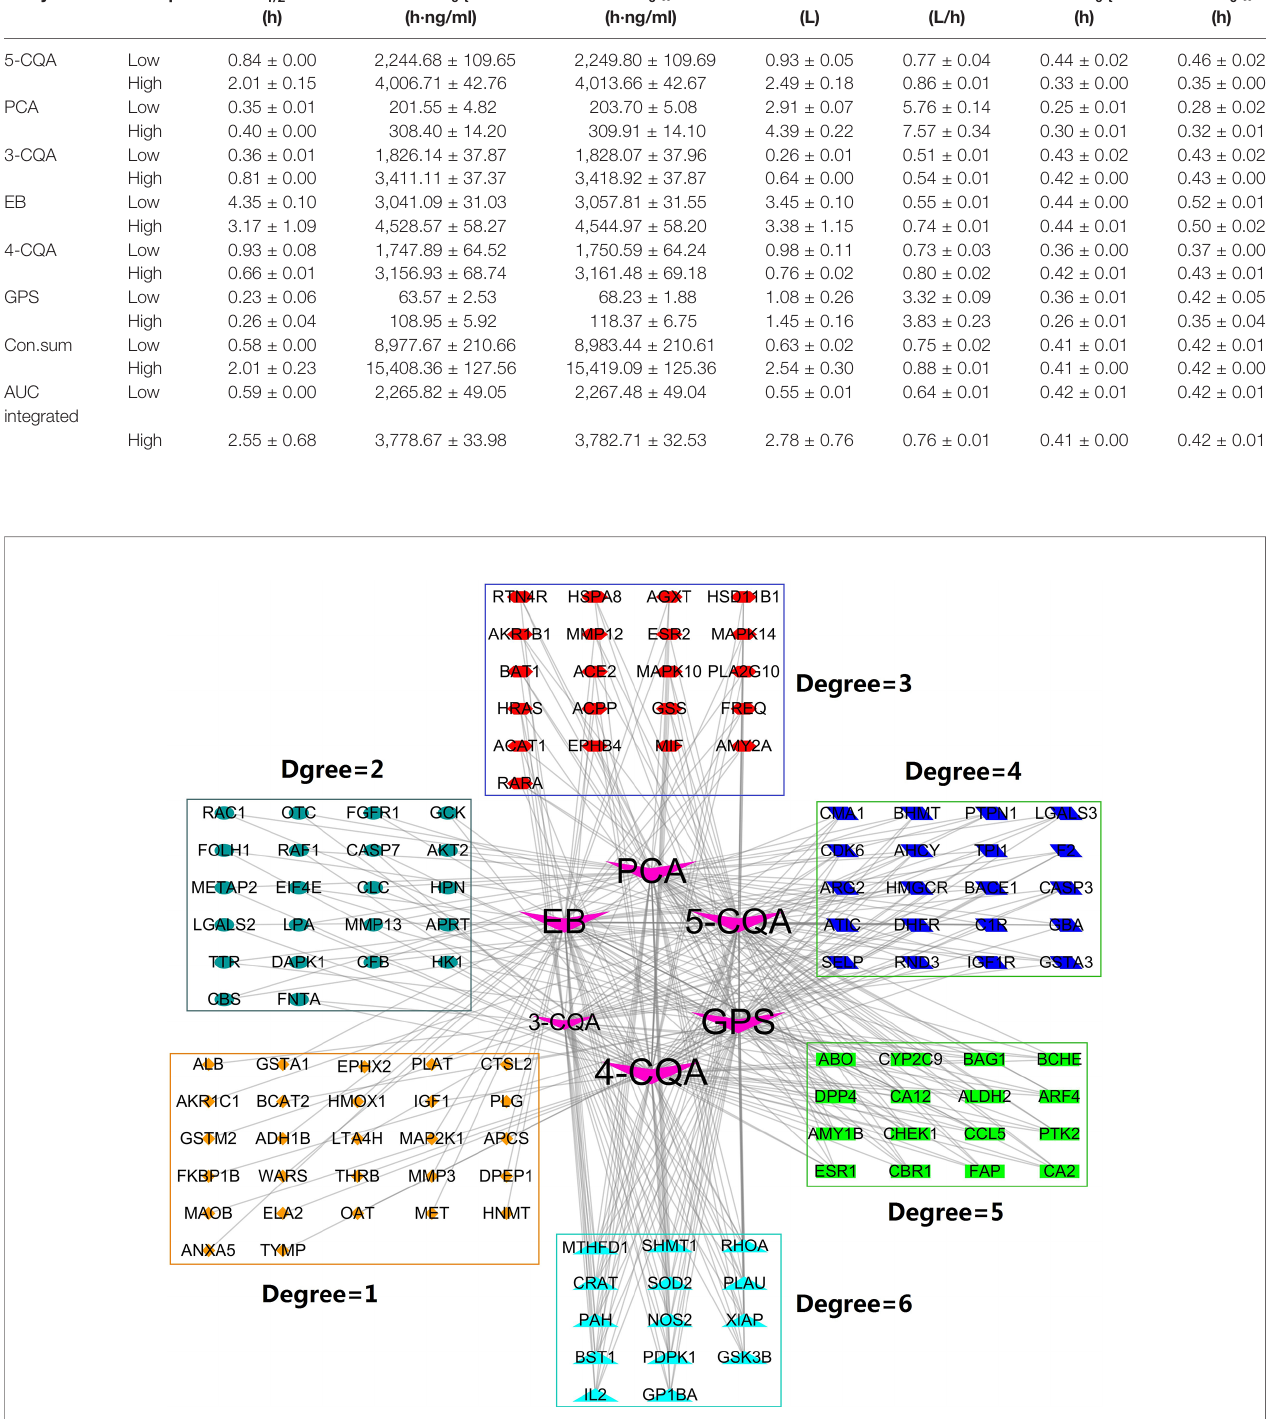
FIGURE 3 | Compound-Target (C-T) network. V shape nodes represent compounds, which go counterclockwise from 4-CQA to 3-CQA according to their degree size. The other shapes represent the potential targets and clustered in rectangles according to their degree values.